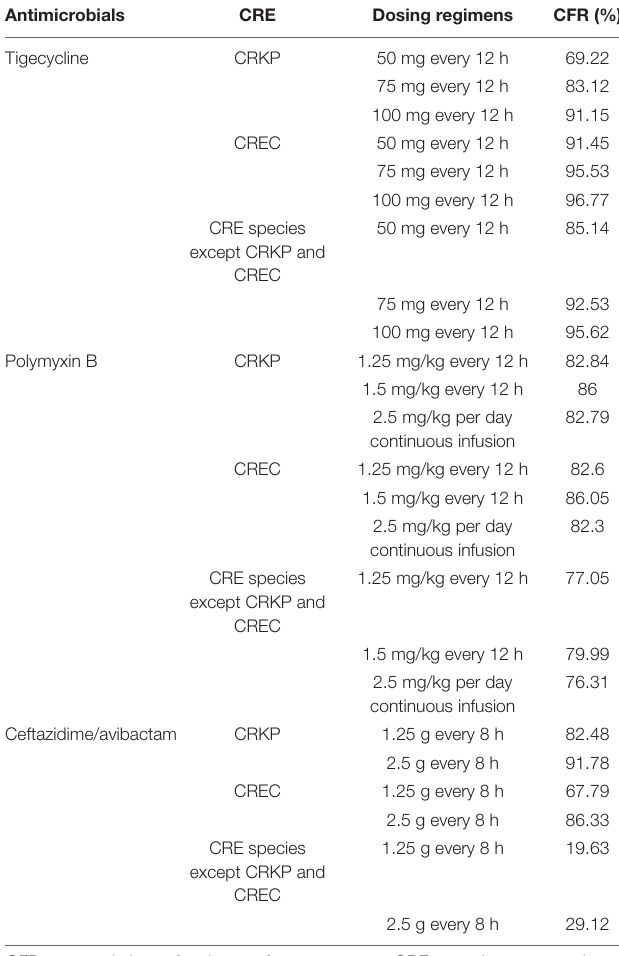
TABLE 5 | CFR values for three antibiotics against CRE. Antimicrobials